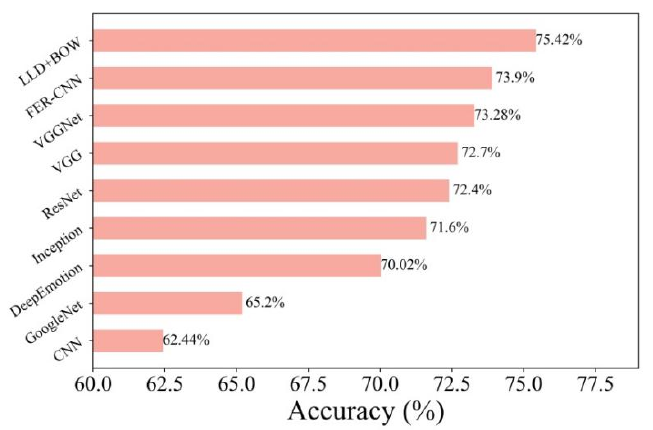
Figure 3. Comparison of the SOTA technique and FER-CNN algorithm based on the FER2013 da- taset.